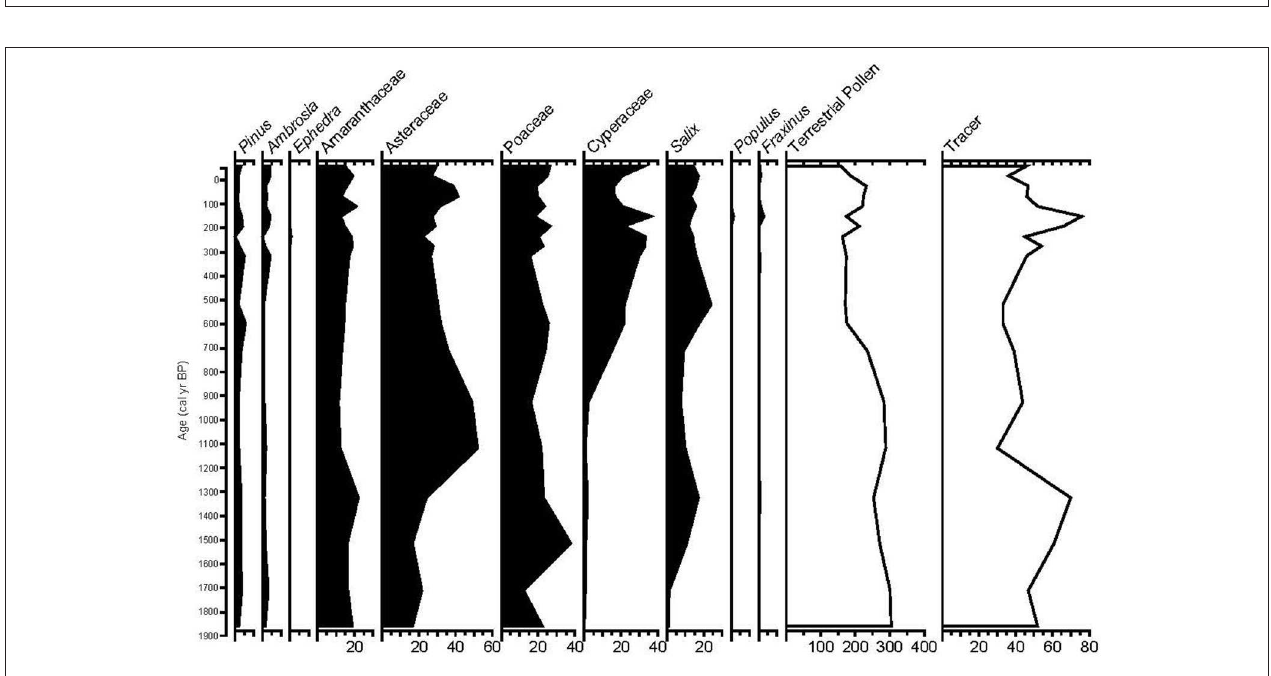
FIGURE 6 | Babocamari pollen diagram.